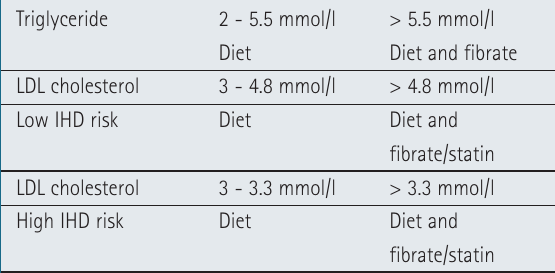
TABLE XI. MANAGEMENT OF HYPERLIPIDAEMIA IN PATIENTS ON PI